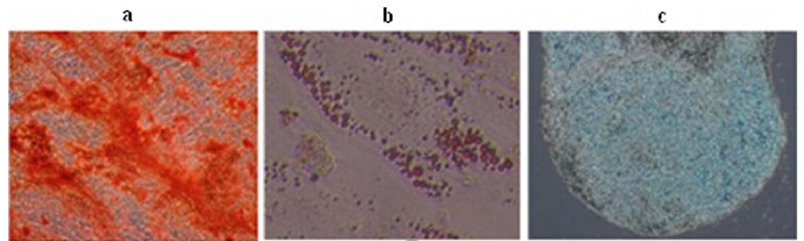
Figure 3. Differentiation of hUC-MSCs from donor 3 was showed at the 15 th passage. (a) Alizarin Red S staining to detect osteogenesis differentiation. (b) Oil Red O staining to detect adipogenesis differentiation. (c) Alcian Blue staining to detect chondrogenic differentiation.